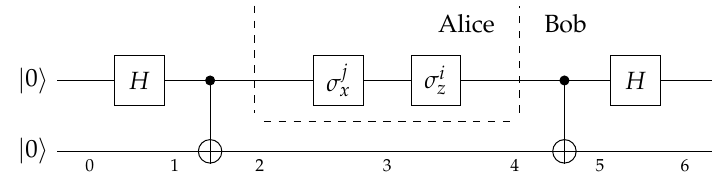
Figure 1. Network representing the superdense coding protocol.